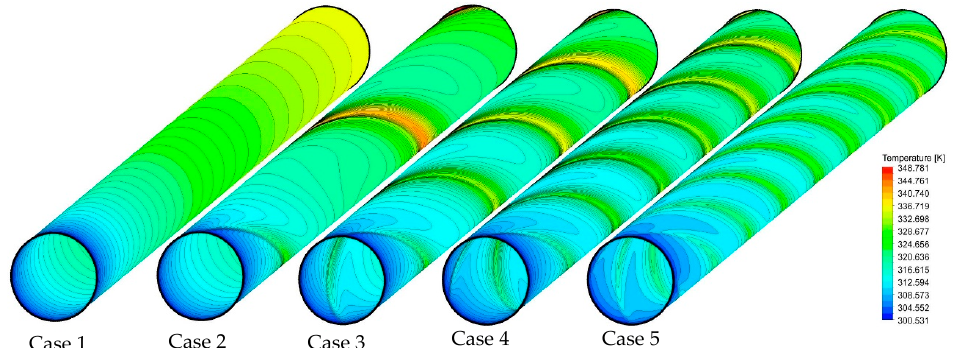
Figure 7. Temperature contours on the heated wall for the captured cases at Re = 250 and φ = 0%.